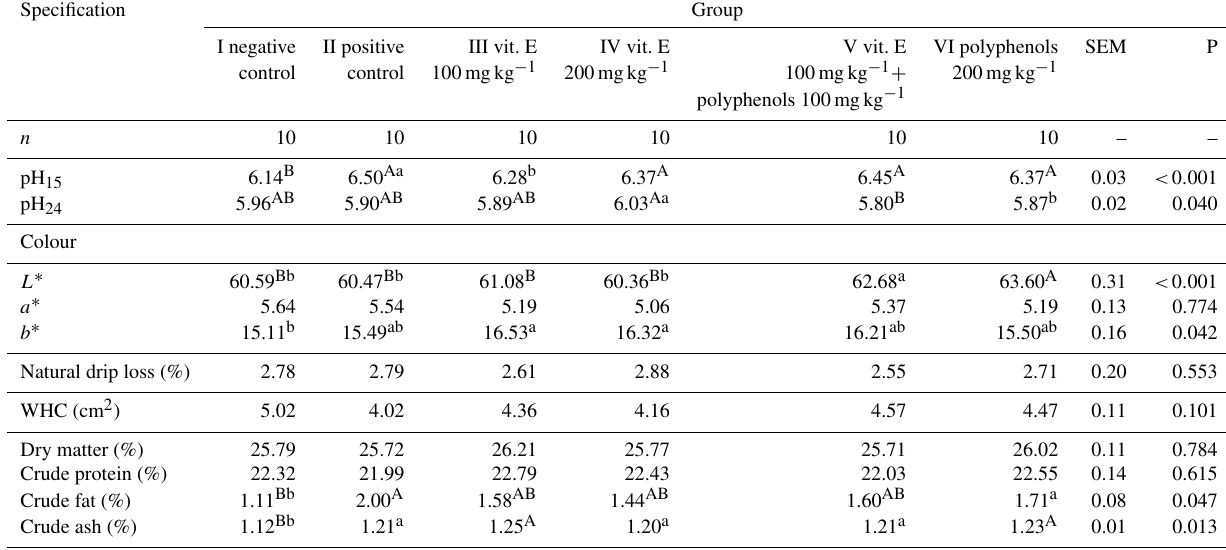
Table 6. Physicochemical properties of breast muscles in broiler chickens fed low-quality oil. WHC stands for water-holding capacity. Specification